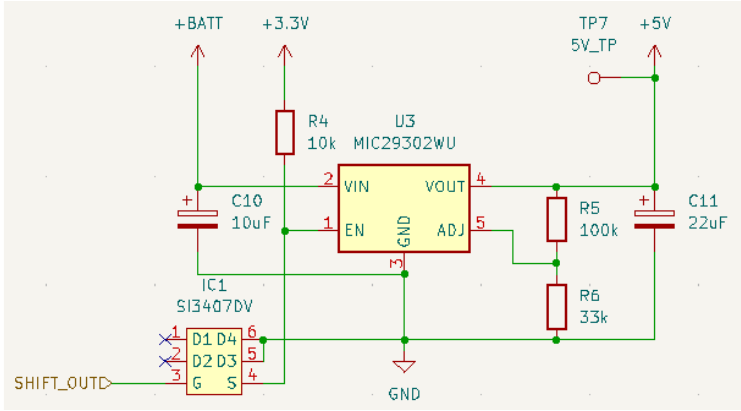
Figure 4. Schematic of the 5 V regulator.